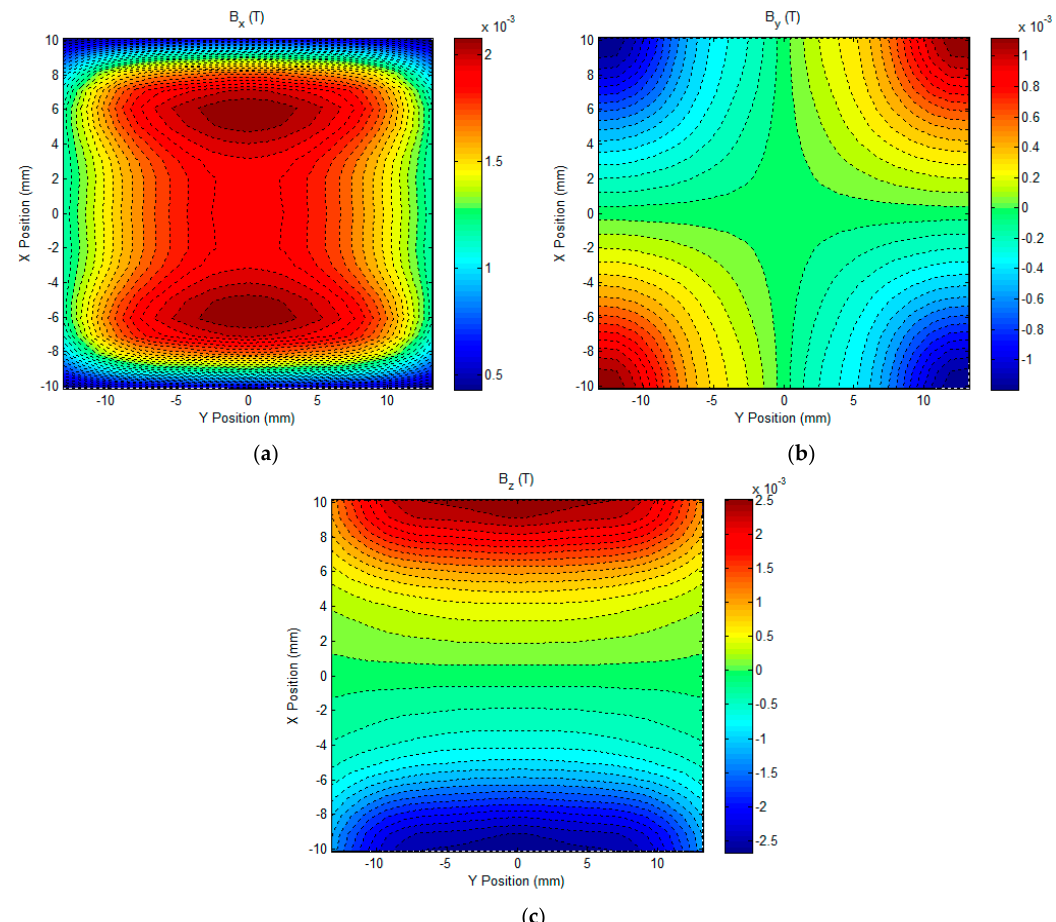
Figure 6. The computed net magnetic field above the plate upper surface. ( a ) B x ; ( b ) B y ; ( c ) B z .